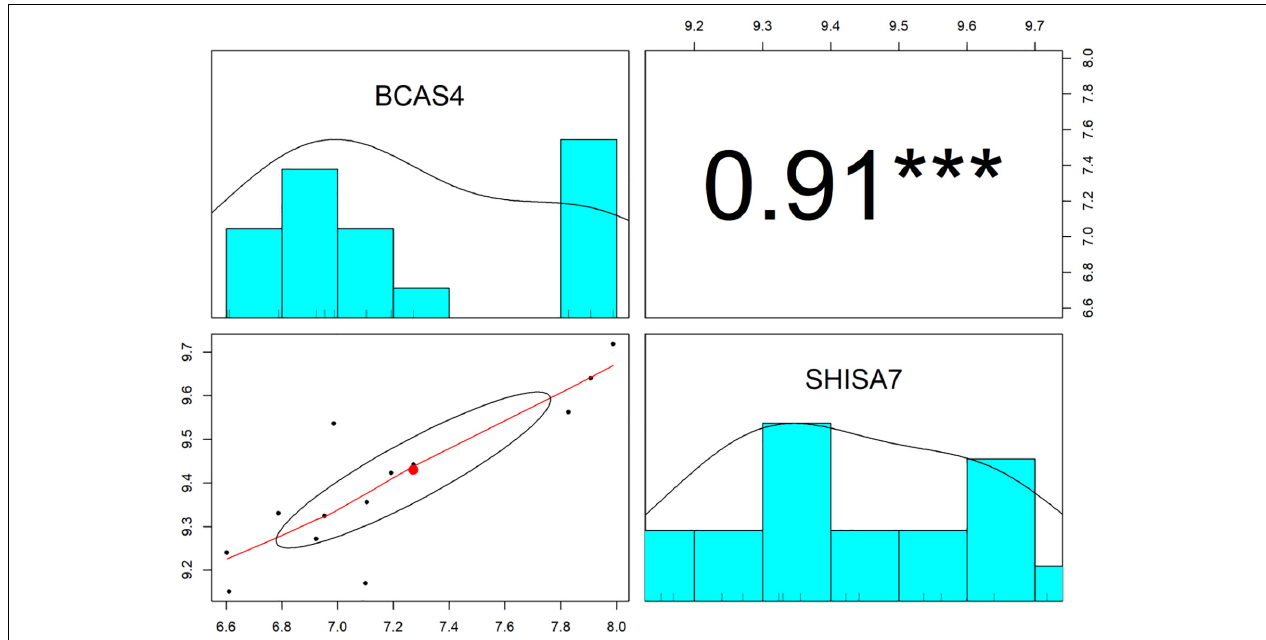
FIGURE 3 | The distribution of each variable is shown on the diagonal. The lower portion of the diagonal shows bivariate scatter plots with a fitted line. On the upper part of the diagonal, the correlation coefficients plus the significance level as stars are displayed. *** is significant correlation at P -value < 0.001.